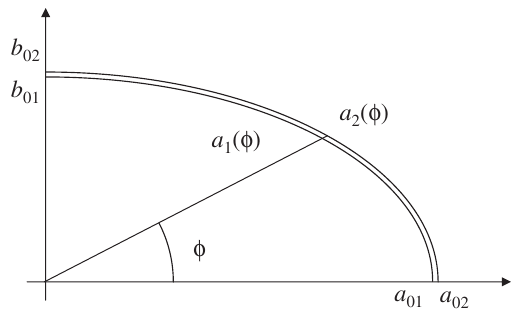
FIG. 1. Cross-sectional view of symmetric on quarter elliptical beam tube. The a 1 ð (cid:4) Þ , a 2 ð (cid:4) Þ are inner and outer radii. The thick- nesses on the horizontal and vertical axes are equal: ð a 02 (cid:2) a 01 Þ ¼ (cid:2) b Þ . The effective radius is defined as R ð (cid:4) Þ ¼ ½ a ð b 02 01 ð (cid:4) Þ(cid:4) = 2 and generalized thickness D ð (cid:4) Þ ¼ a a 2